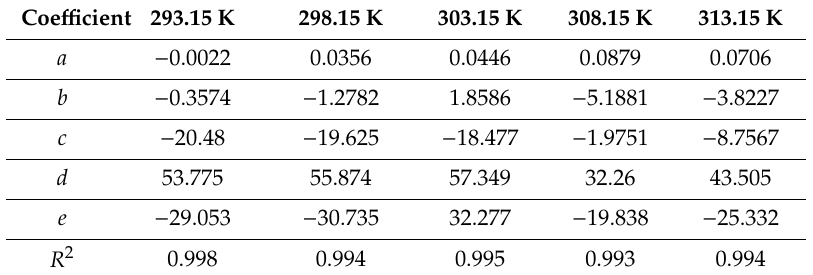
Table 4. Coe ffi cients of the Equation (22) to Gibbs energy of transfer of amygdalin (3) at several temperatures.